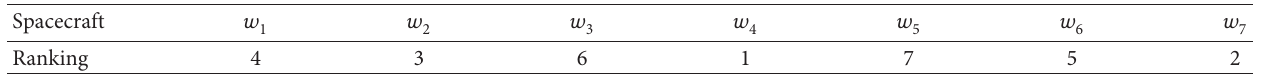
Table 27: Hierarchical ranking of spacecraft.